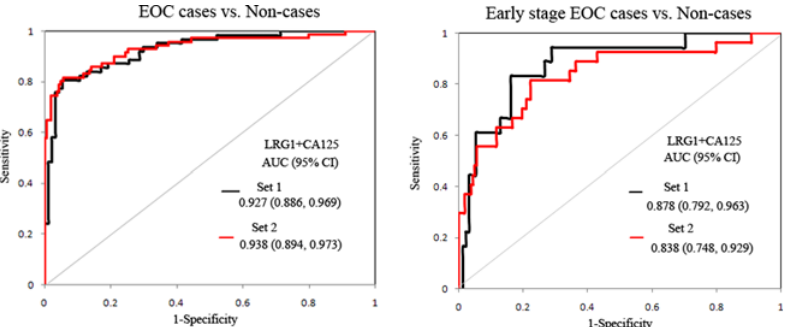
Fig 5. Multimarker panel analysis. The performance of multimarker panels in distinguishing EOC/ early stage EOC from non-cases using sample set 1and sample set 2.